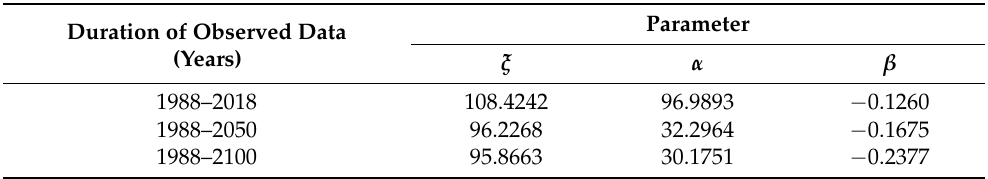
Table 7. Parameters calculated by GEV distribution using L-moment method considering RCP 8.5 scenario at Gimhae rainfall station.